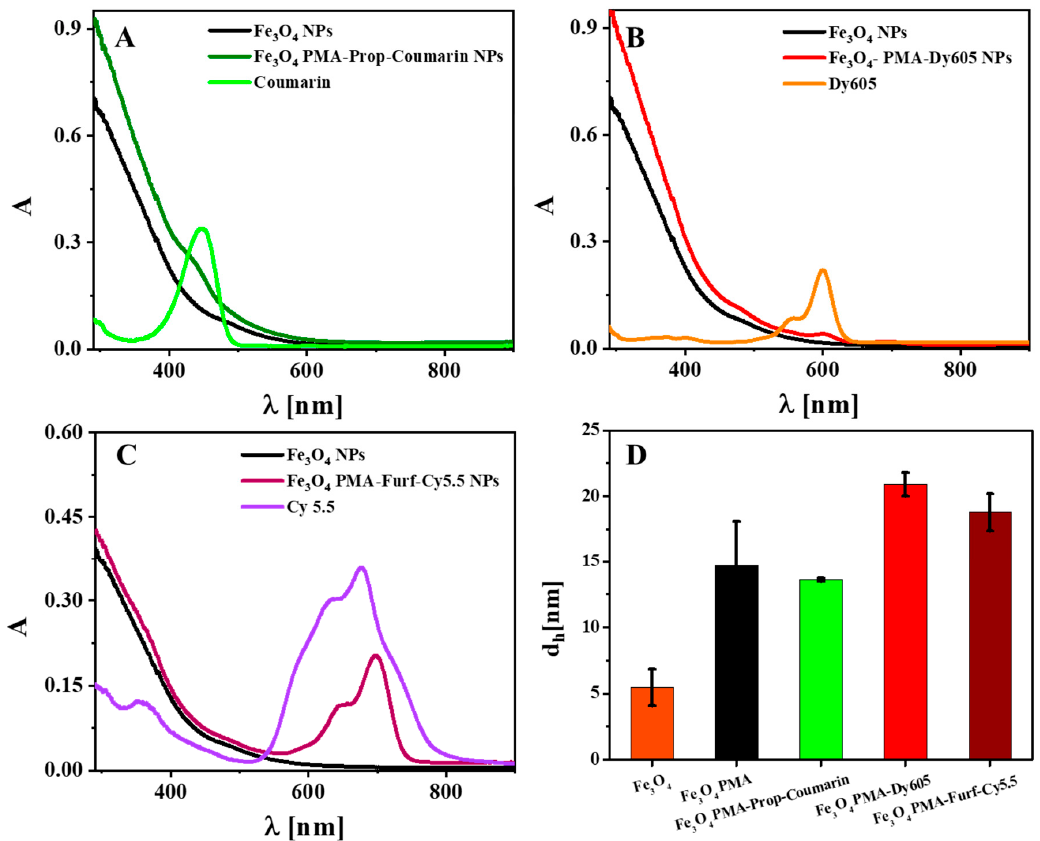
Figure 1. UV-vis absorption spectra A( λ ) of ( A ) Fe 3 O 4 poly-(isobutylene-alt-maleic anhydride)-graft-dodecyl (PMA)-propargylamine (Prop)-Coumarin nanoparticles (NPs), ( B ) Fe 3 O 4 PMA- Dyomics, #605-02 (Dy605) NPs, ( C ) Fe 3 O 4 PMA-furfurylamine (Furf)-Cy5.5 NPs, as well as Fe 3 O 4 PMA and free dyes. ( D ) Hydrodynamic diameter d h of Fe 3 O 4 NPs as dissolved in chloroform, Fe 3 O 4 PMA NPs and Fe 3 O 4 NPs conjugated with three different dyes in